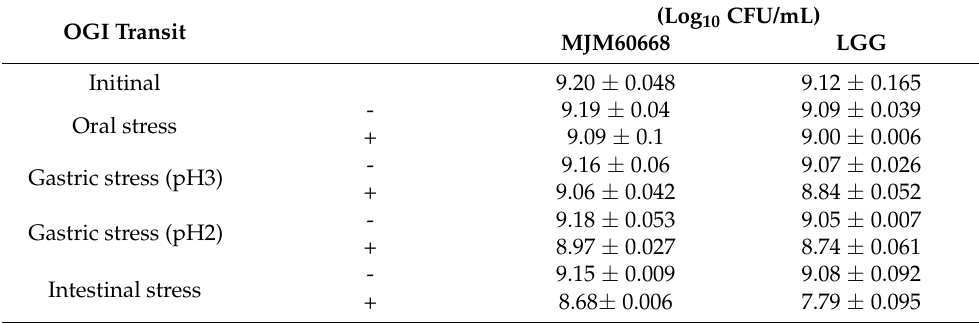
Table 4. Antibacterial activity of L. reuteri MJM60668 and L. rhamnosus GG. OGI Transit